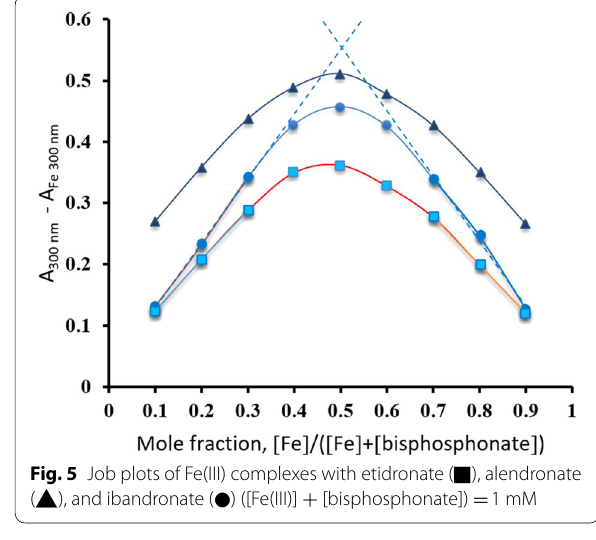
[bisphosphonate]) 1 mM + =